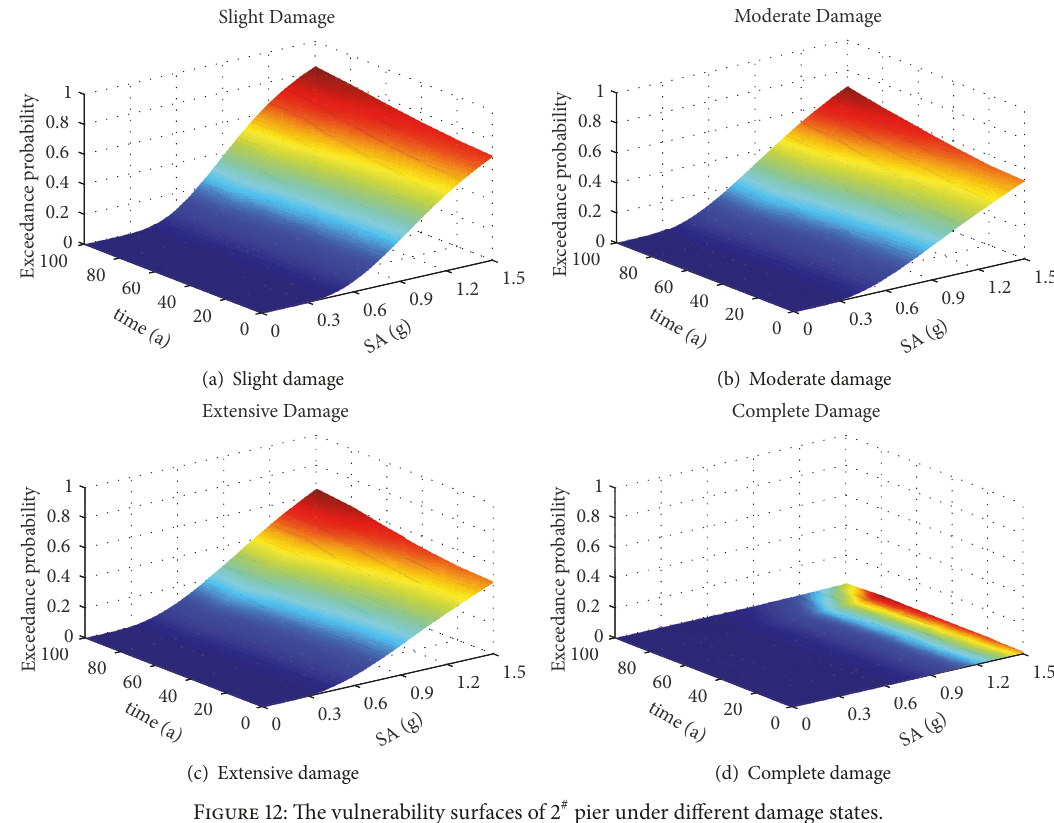
Figure 12: The vulnerability surfaces of 2 # pier under different damage states.